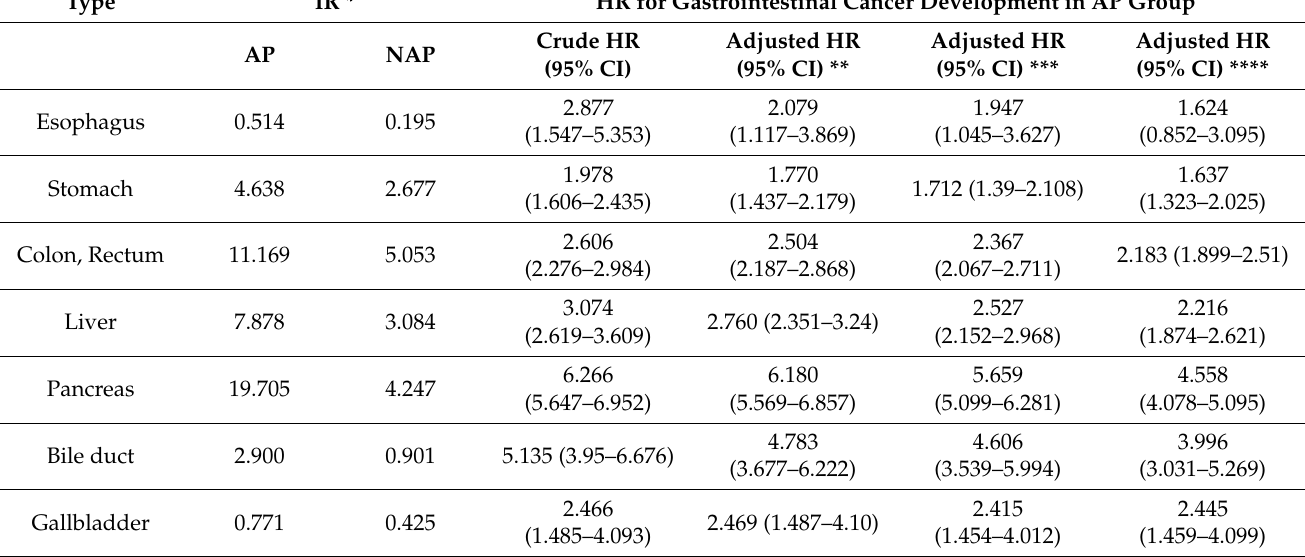
Table 3. Incidence rates and risk for gastrointestinal cancers in diabetic patients according to history of acute